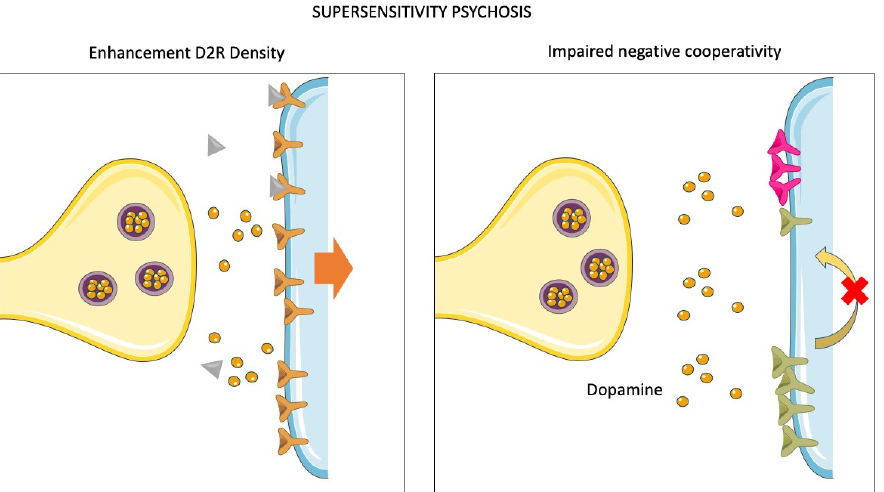
Figure 3. Molecular mechanisms of supersensitivity psychosis. Dopamine supersensitivity psychosis (DSP) is a condition of acquired treatment resistance. An accurate definition requires three clinical features: (1) re-appearance of positive psychotic symptoms despite ongoing antipsychotic therapy; (2) abnormal involuntary movements; (3) absent or negligible life events exacerbating the psychosis. The figure illustrates two different putative mechanisms involved in the pathophysiology of the DSP-acquired form of TRS. Left panel: chronic or subchronic exposure to antipsychotics yields an adaptation of postsynaptic sites, which increase D2R expression on the membrane to overcome receptor blockade and diminish D2R-mediated downstream signaling. Right panel: under physiological circumstances, D2Rs can aggregate in oligomers. The binding of dopamine to one D2R causes, in turn, the unoccupied receptors to switch to a low-affinity state. The disruption of this mechanism of “negative cooperativity” is supposed to cause a condition of supersensitivity to dopamine. Indeed, antipsychotics would no longer be able to block downstream